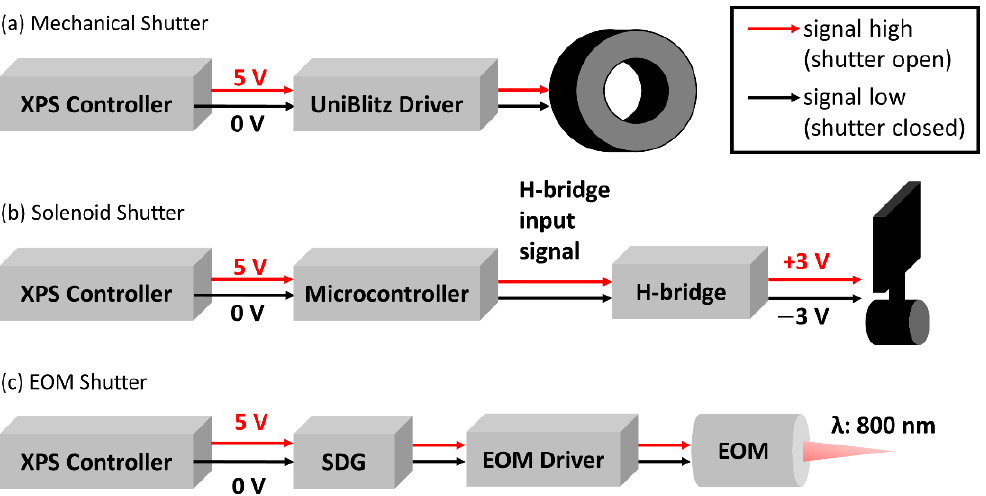
Figure 2. Box chart visualizing the signal pathway for each shutter. ( a ) Mechanical shutter. ( b ) Solenoid Shutter. ( c ) EOM shutter.